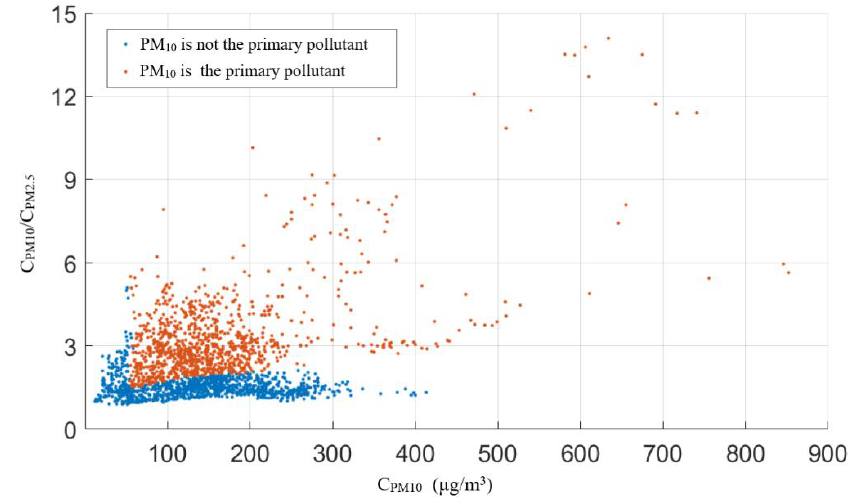
Figure 2. Scatter distribution of experimental data (Xi ’ an, 1 February to 30 April